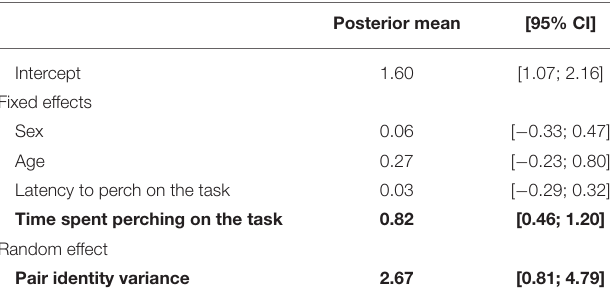
TABLE 1 | Influence of age, sex, latency to perch on the task and time spent perching on the task before the first entrance on the learning score [from 1 (fast learners) to 5 (slow or non-learners)].